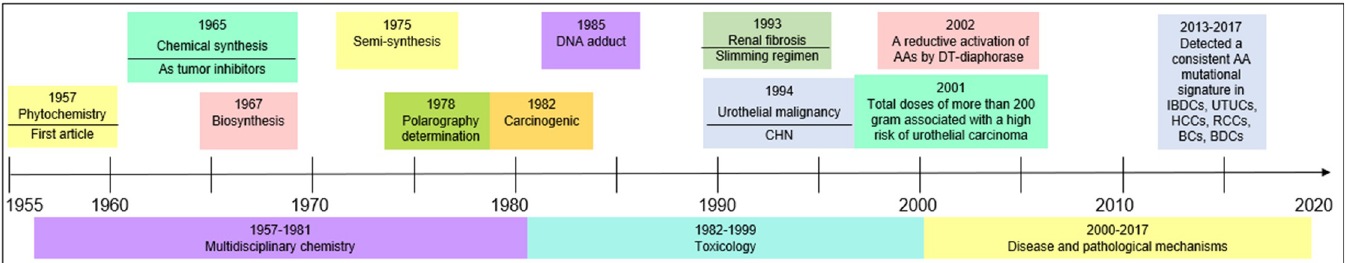
Fig 8. Roadmap of the historical development of AA-related research.